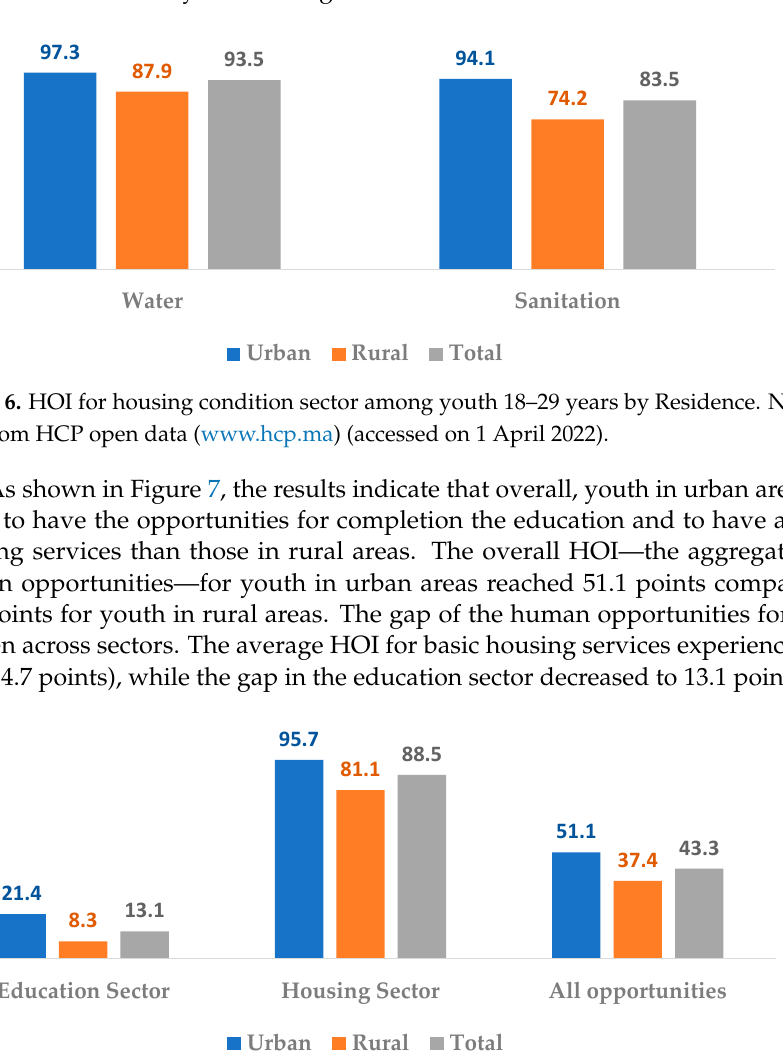
Figure 5. HOI for education sector among youth 18–25 years by Residence. Note: Authors, data from HCP open data (www.hcp.ma) (accessed on 1 April 2022).